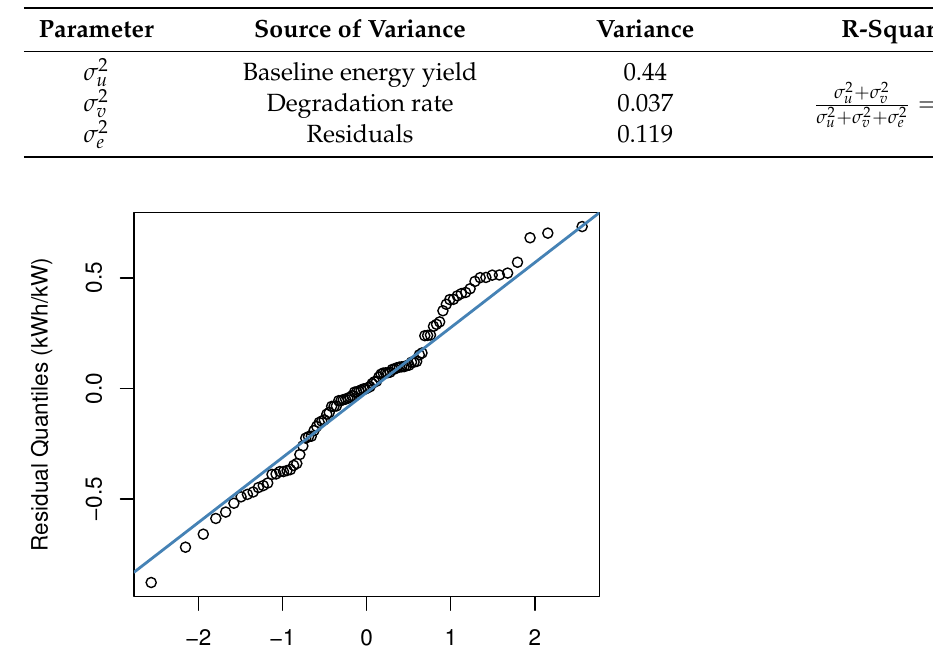
Table 7. The random-effects results of the linear decline model based on the MEM in Equation (8).